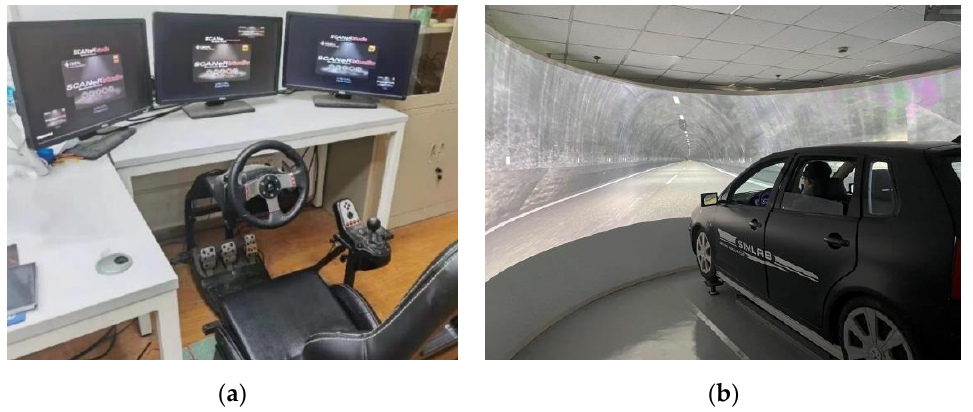
Figure 1. Driving Simulation Experimental Apparatus. ( a ) Driving simulator used in car following experiment. ( b ) 3-degree of freedom motion-based driving simulator.